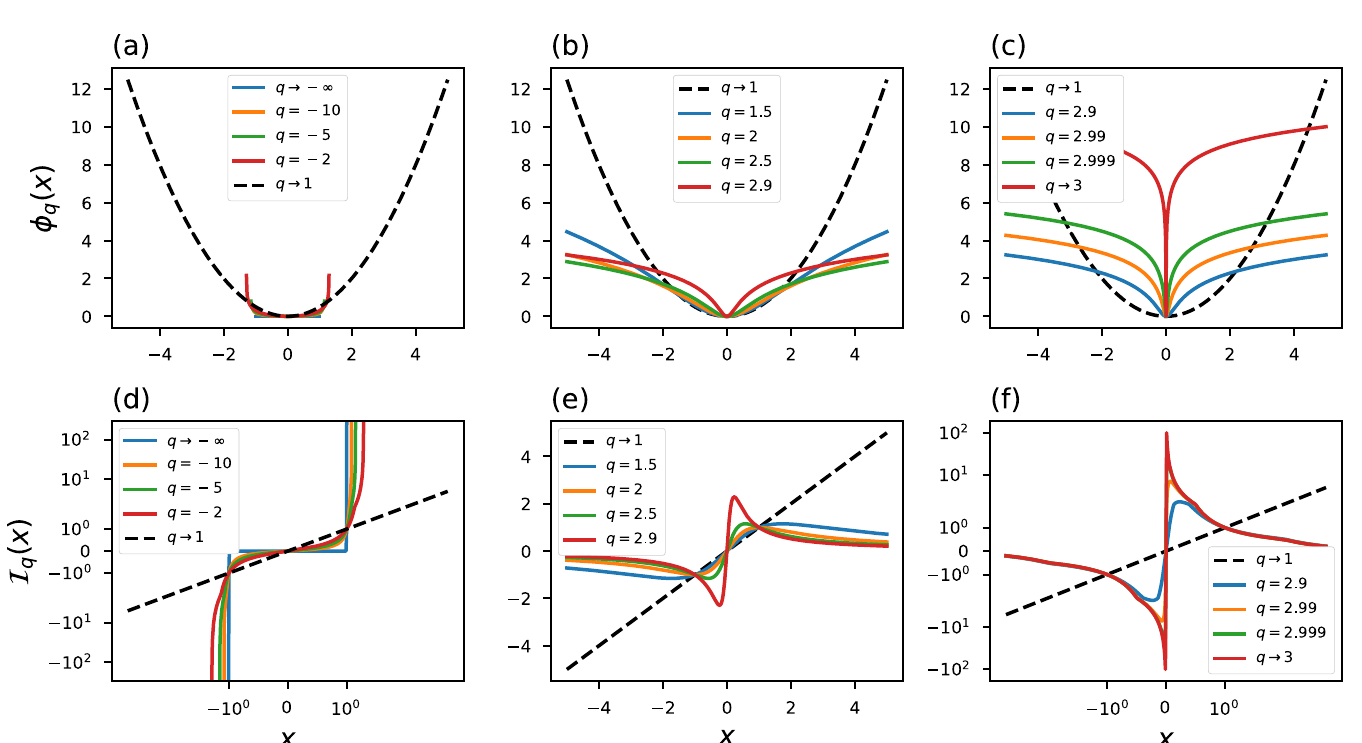
Fig 5. (a)-(c) objective functions and (d)-(f) generalized influence functions based on Tsallis statistic. The black dashed line represents the conventional curves.